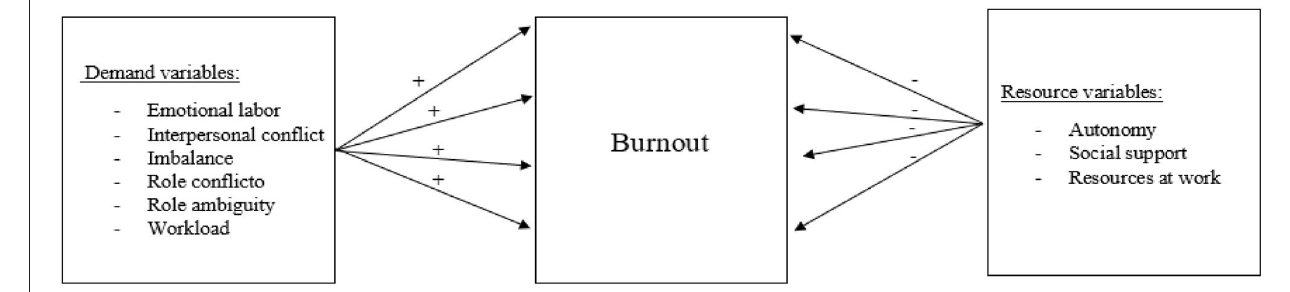
FIGURE 1 | Hypothesis 1 and 2.